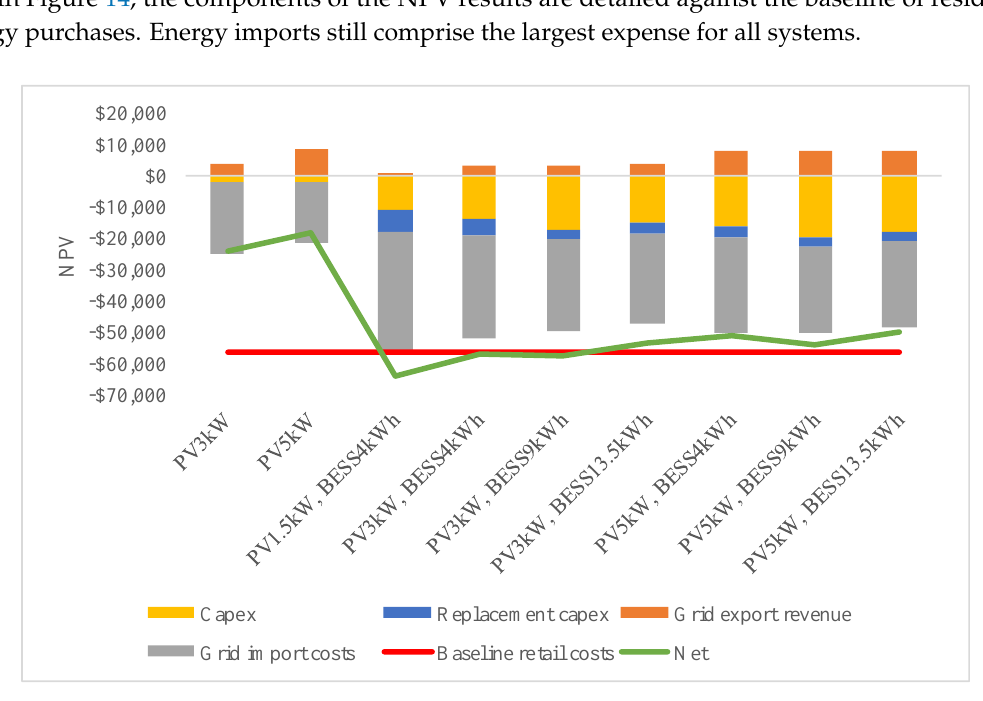
Figure 14. NPV value stack.